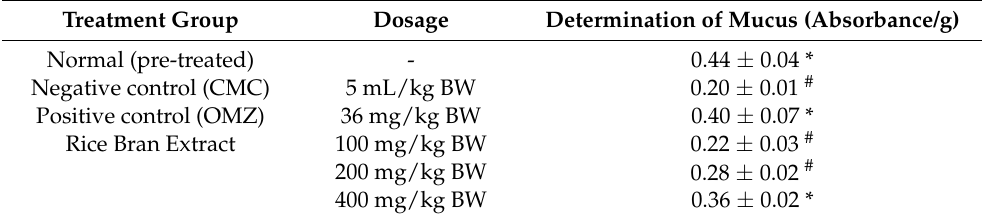
Table 3. The effect of rice bran extract on mucus in gastric content-induced by